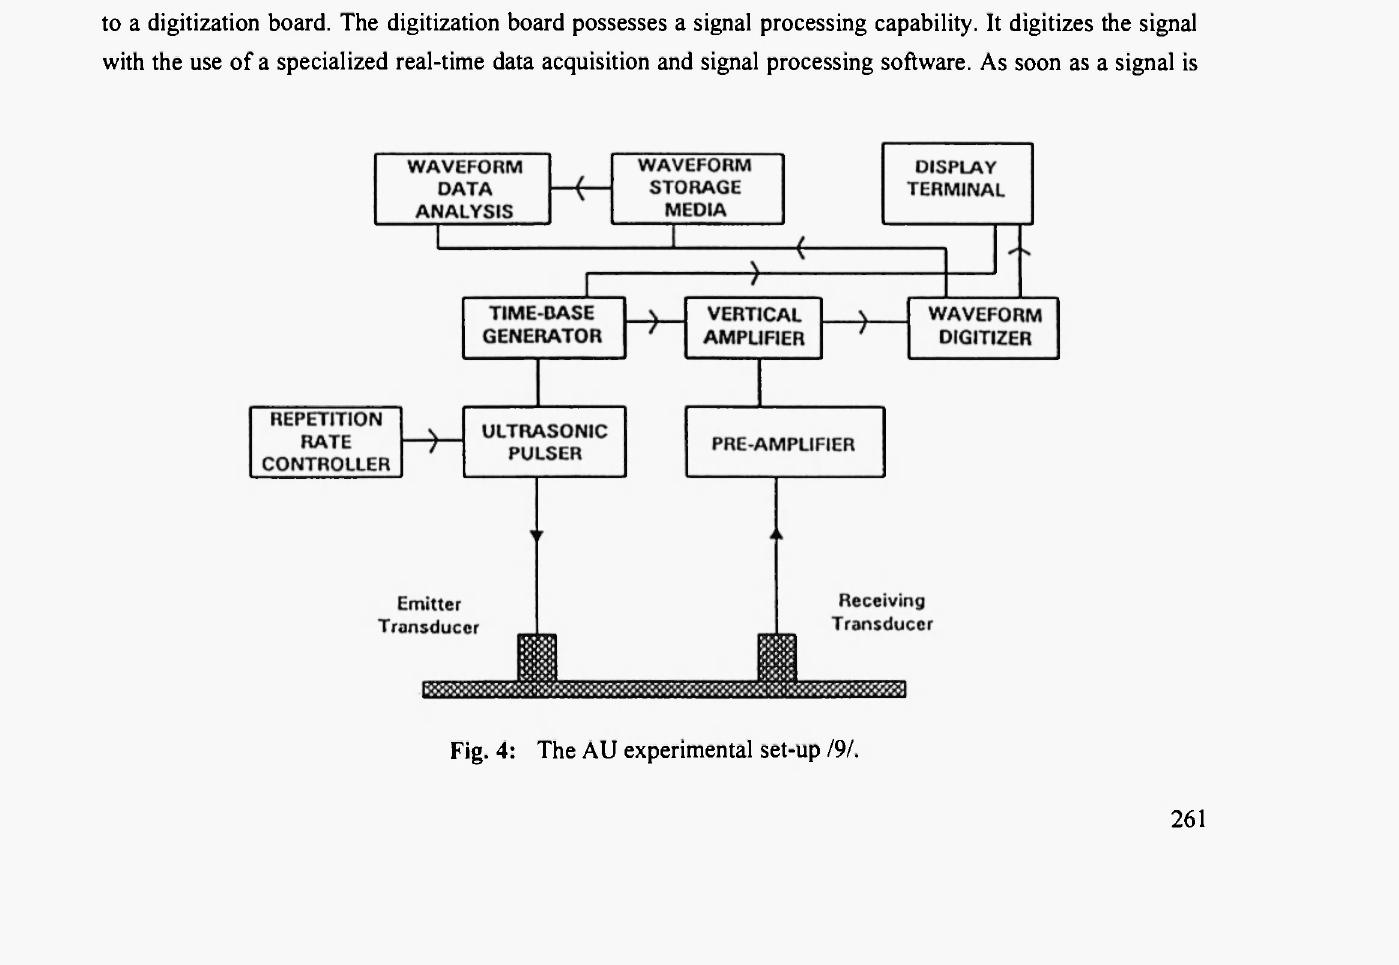
Fig. 4: The AU experimental set-up